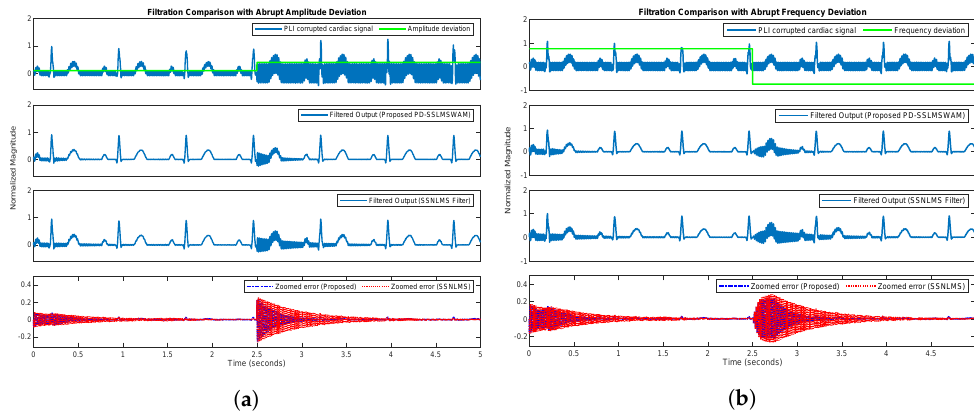
Figure 10. Filtration comparison between the proposed PD–SSLMSWAM and SSNLMS adaptive filters for PLI-corrupted cardiac signals.( a ) Abrupt changes in amplitude; ( b ) abrupt changes in the frequency of the composite PLI